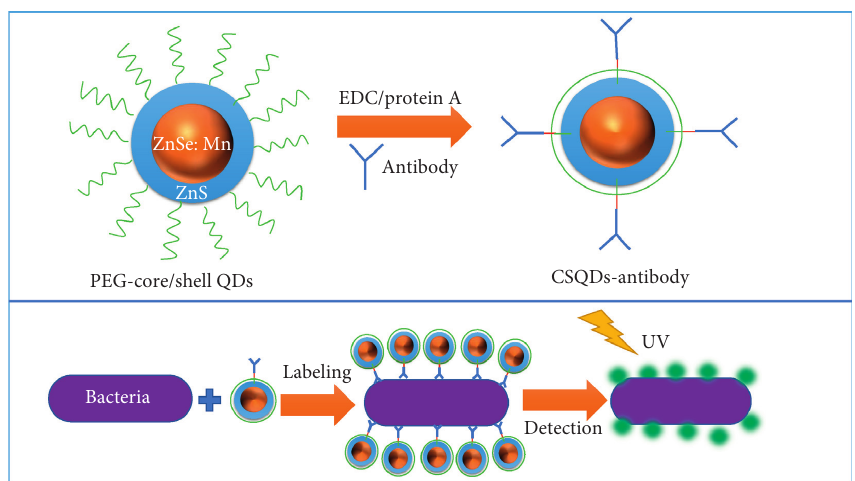
Scheme 1: Schematic representation of the CSQDs-antibody structure and the bacteria